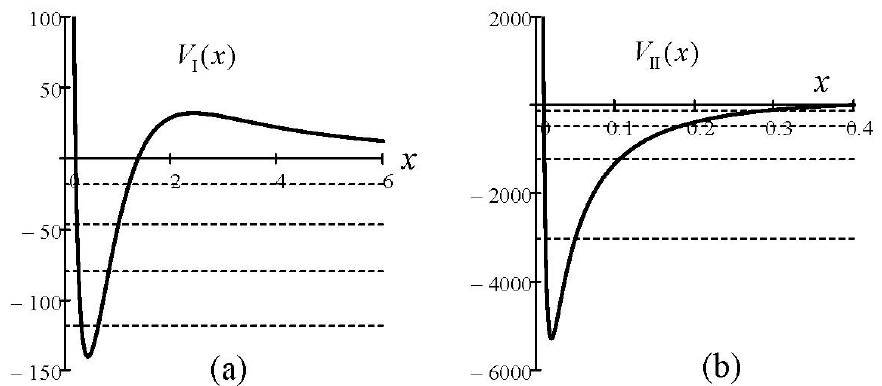
Figure 4. The two potential functions with their energy spectra superimposed. The physical parameters and results of Tables 1 and 2 are used. One can observe the three features of V II ( x ) ( b ), mentioned at the end of Section 3, which are the source of deficiency in the computational accuracy compared to V I ( x ) ( a